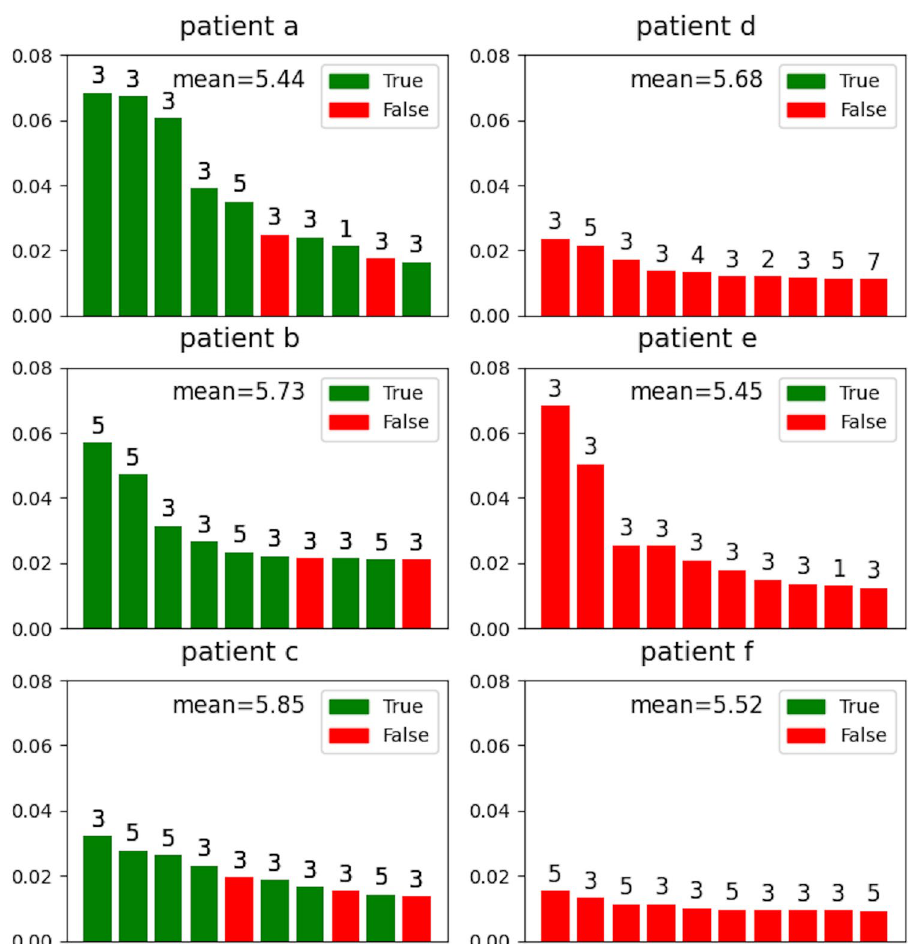
Figure 4. Examples of drug imputation for the 3 most accurately imputed patients and the 3 most inaccurately imputed patients. Each panel displays top 10 imputed drugs of a patient. The height and color of each bar indicates the imputed probability and its correctness, respectively. Annotated above each bar is the shortest distance from each imputed ATC to any of the observed ICD codes for the patient. As a reference, the mean distance indicated in each panel is the average distance from all of the ATC codes to observed ICD codes of the same